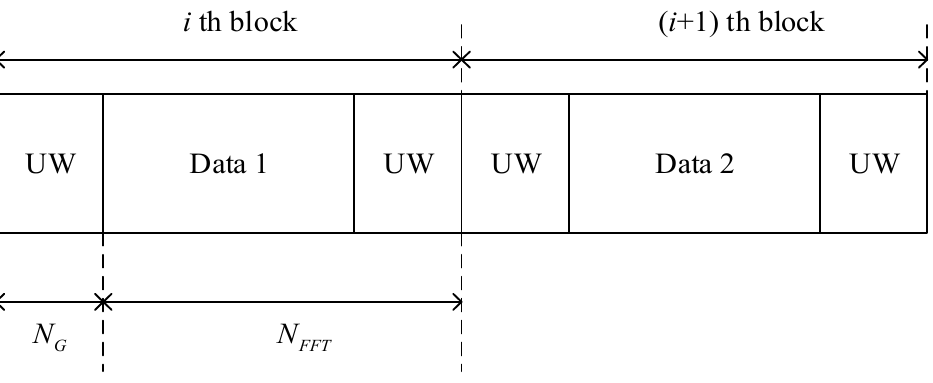
Figure 2. UW-based signal frame structure.